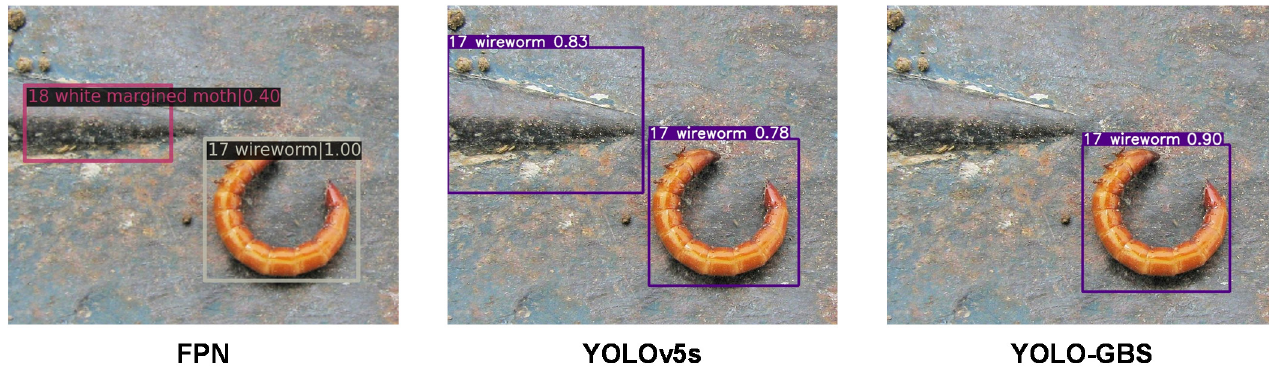
Figure 11. YOLOv5s and FPN misclassified the insect in the lower right corner of the figure; the correct classification is “16 mole cricket”.